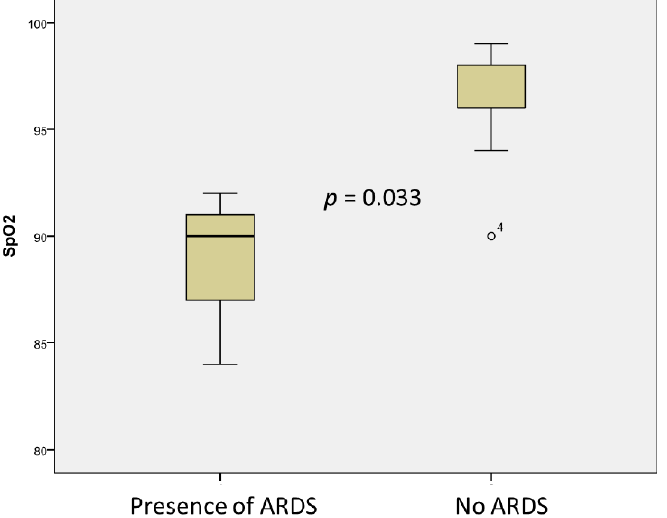
Figure 5. Association of SpO2 with the presence of ARDS in children with MIS-C. °4 denotes an outlier.